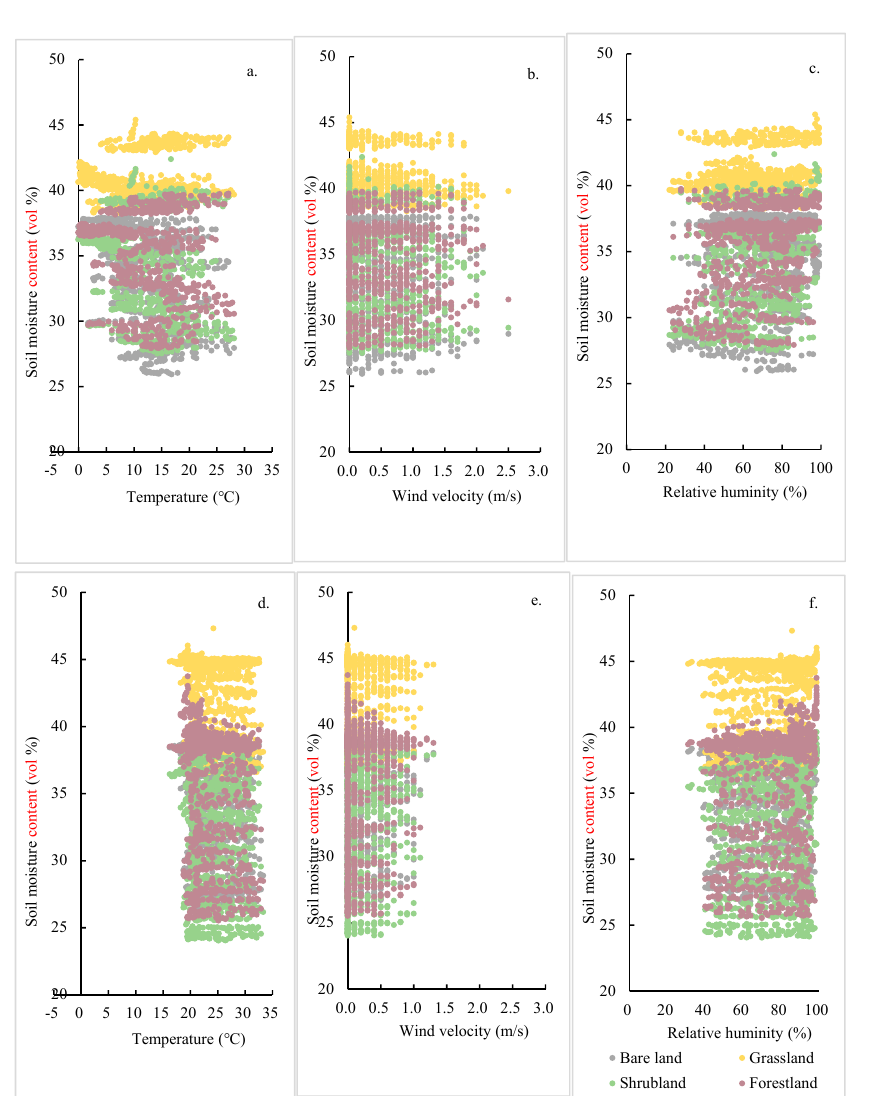
Figure 10. Volumetric soil moisture content, with temperature in the dry season ( a ), wind velocity in the dry season ( b ), relative humidity in the dry season ( c ), temperature in the rainy season ( d ), wind velocity in the rainy season ( e ), and relative humidity in the rainy season ( f ) in a period without rainfall. Table 13. Results of the Spearman correlation coefficient (C) and significance level ( p ) between volumetric soil moisture content, and temperature, wind velocity, and relative humidity in a period without rainfall.